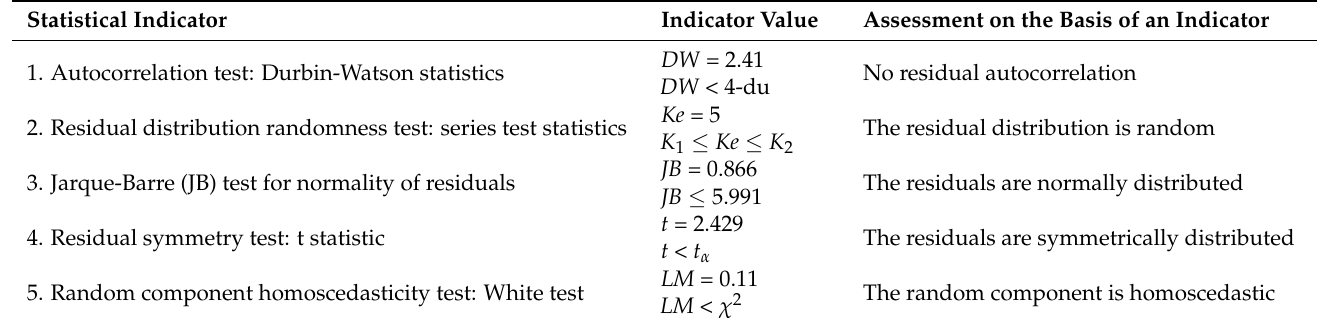
Table 4. Statistical verification of the model no. 2 by using statistical